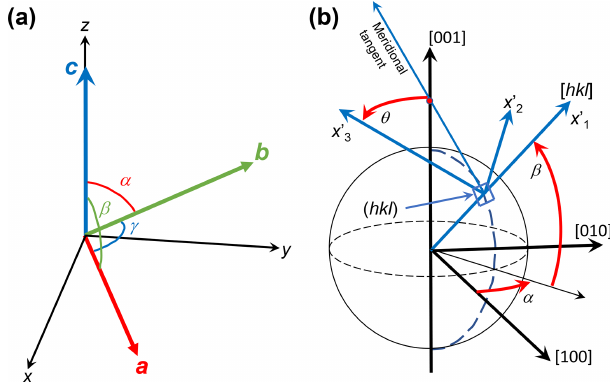
Figure 1. (a) Crystallographic orientation convention (after Britton et al., 2016) and (b) geometrical reference frame (after Turley and Sines, 1971) used in this